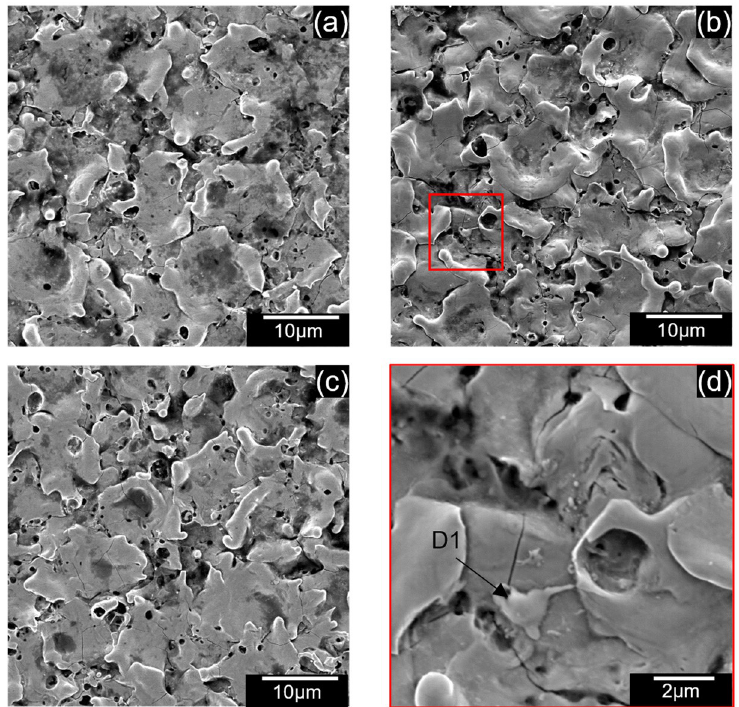
Figure 13. SEM of machined surface using 0.5 g/L carbon nanofibers at ( a ) 90 V ( b ) 100 V, ( c ) 110 V, ( d ) enlarged region of 100 V.